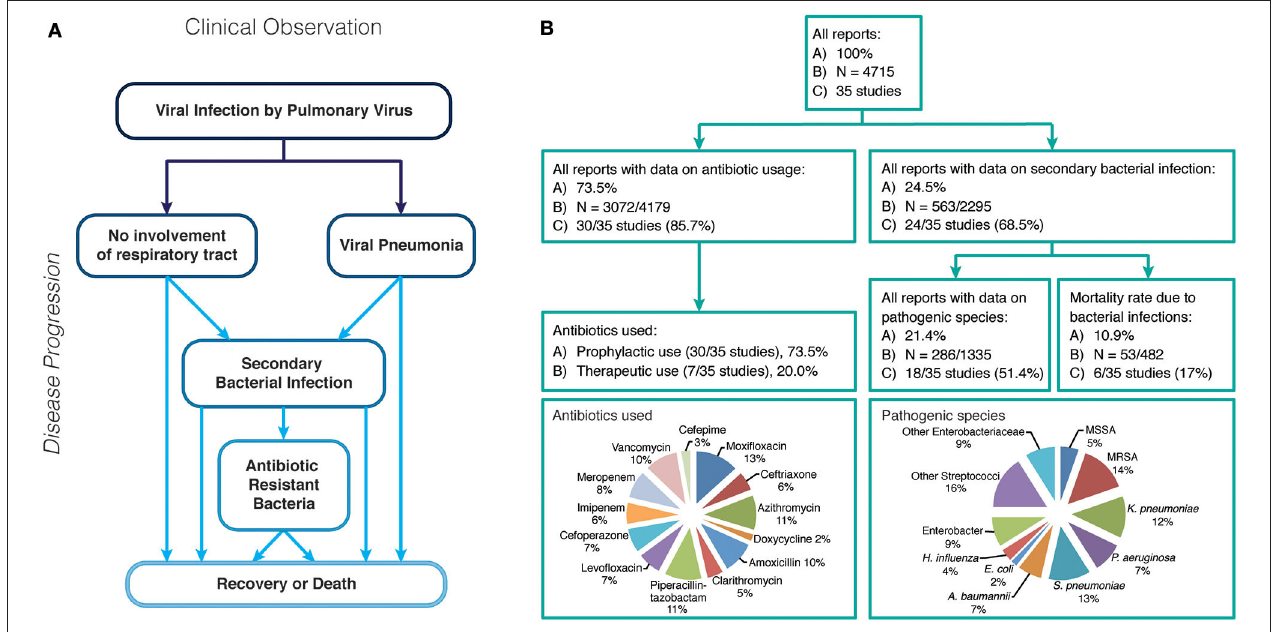
FIGURE 1 | (A) Possible disease progression after infection with a respiratory virus. (B) Overview of case reports of all respiratory virus infection data reviewed in this study, including rate of secondary bacterial infections, antibiotic use and pathogenic bacteria